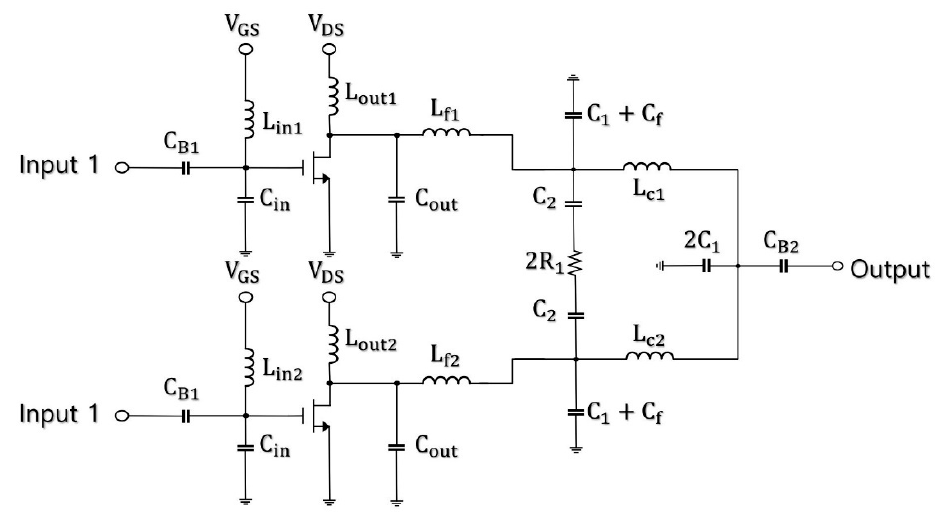
Figure 7. Schematic of the proposed power amplifier module with the adaptive power combiner. Table 1. Comparisons of the performances of the single class-E power amplifier (PA), and the proposed power module using the dual PAs in the schematic simulation.